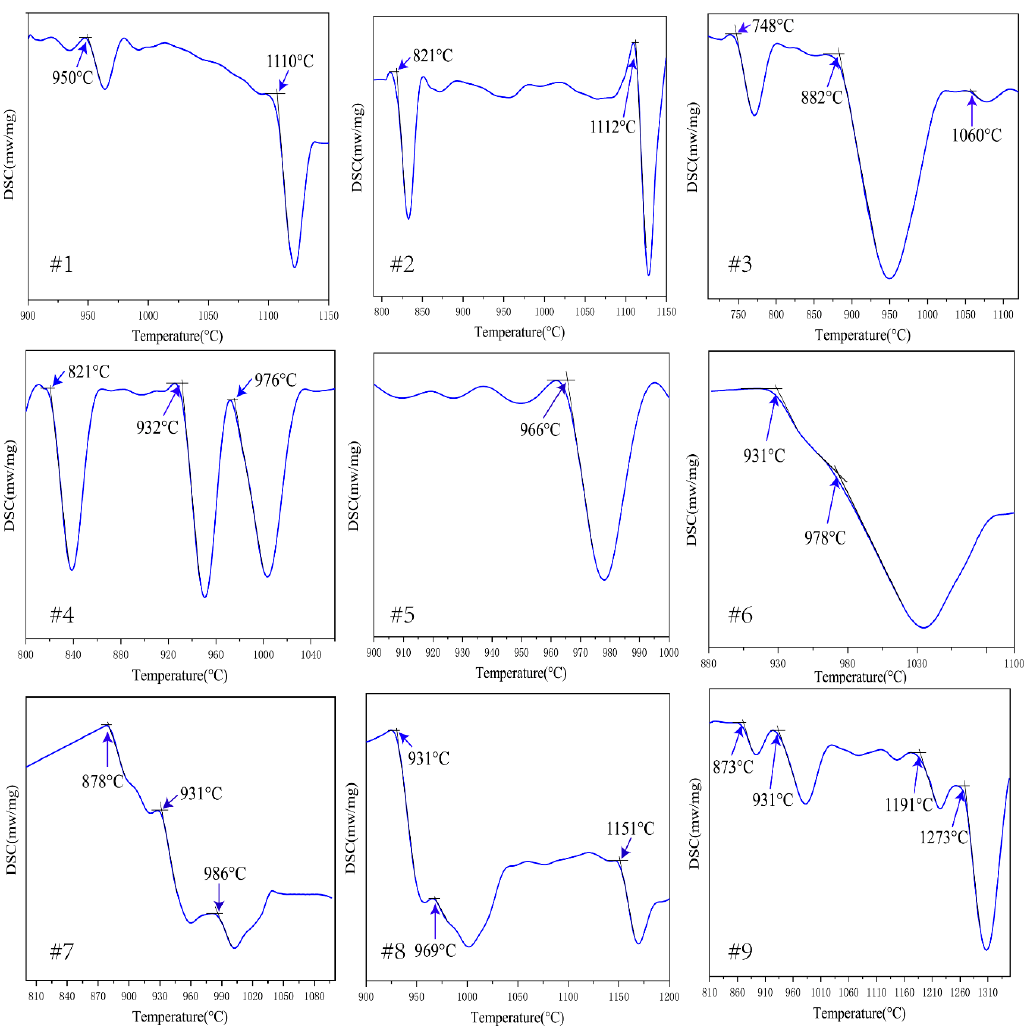
Figure 1. Differential scanning calorimetric (DSC) curves of alloys #1–#9. Figure 1. Di ff erential scanning calorimetric (DSC) curves of alloys